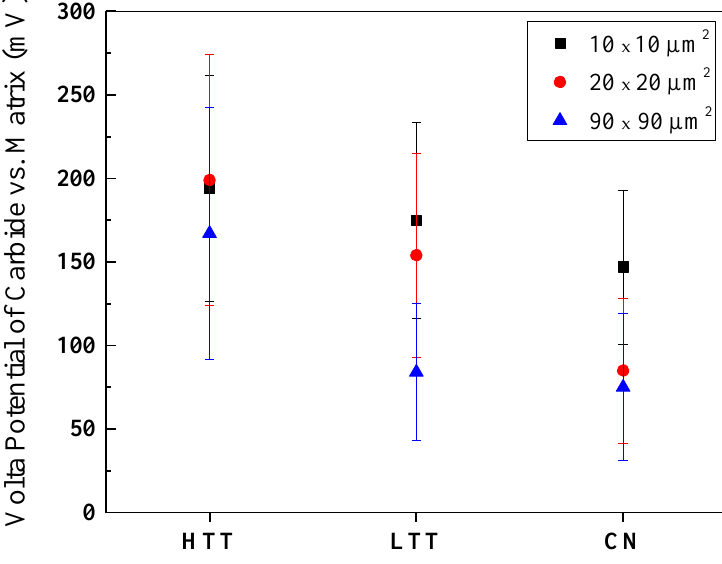
Figure 5. Plot of measured VPDs (with standard deviation error bars) of carbide precipitates versus the surrounding matrix for the three P675 surface-treated steels as a function of scan area.